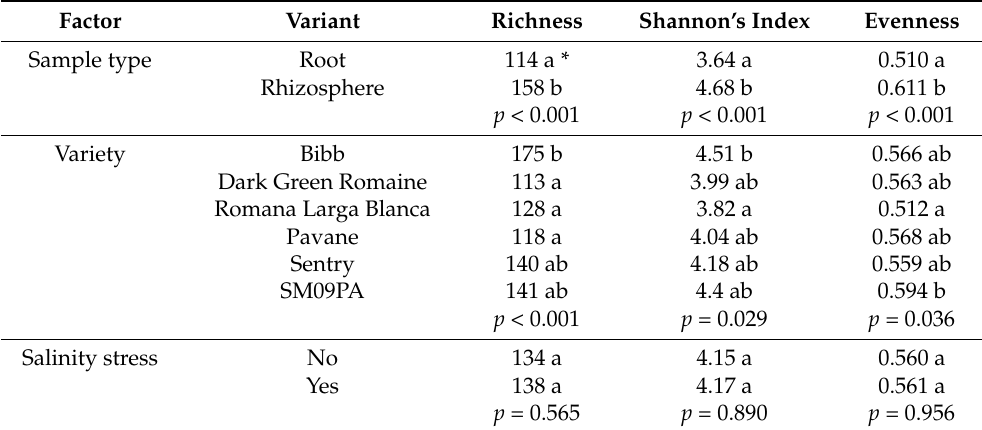
Table 2. Alpha diversity indices of fungal microbiomes in root and rhizosphere of six varieties of lettuce under normal conditions and salinity stress.